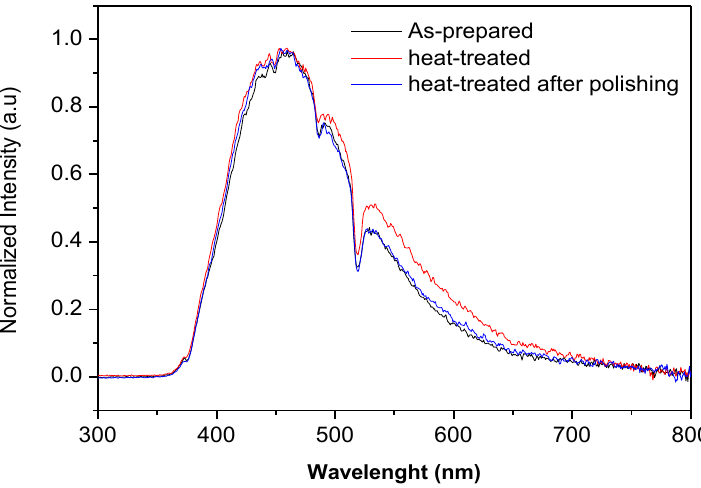
Figure 8. Normalized visible photoluminescence (PL) spectra of Ag 2 glasses taken as an example.